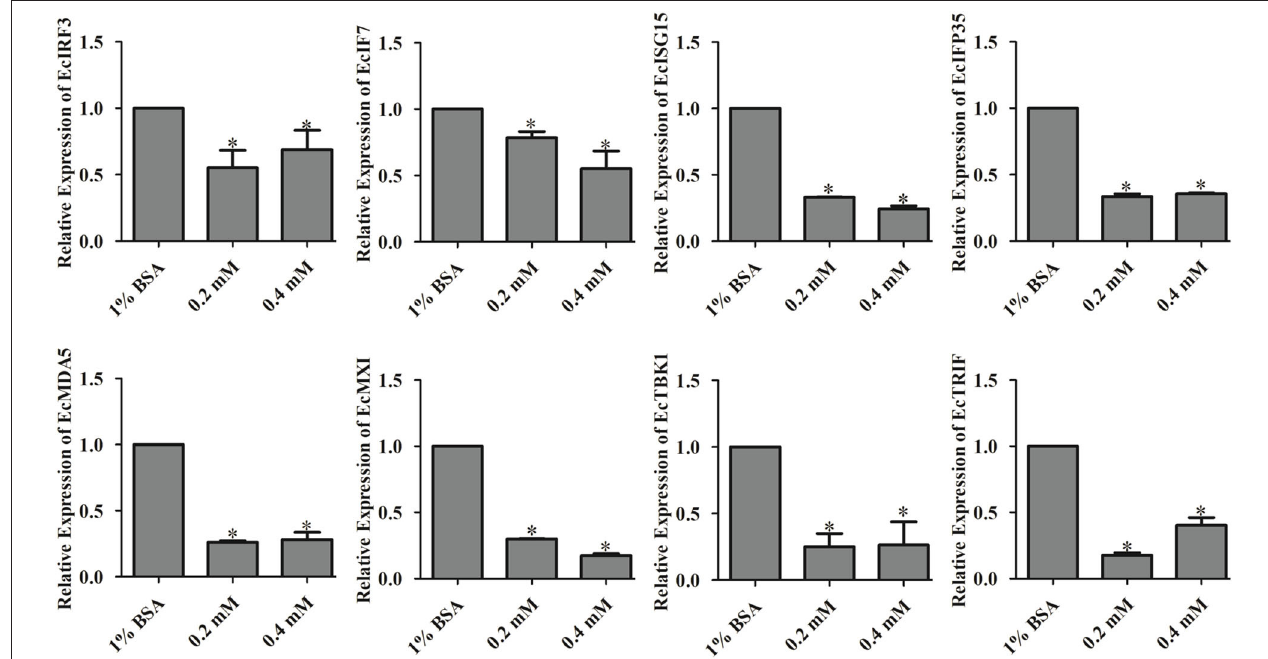
FIGURE 6 | Palmitic acid decreased the expression of interferon related cytokines or effectors. GS cells were incubated with the indicated concentration of palmitic acid (0.2 or 0.4mM) or 1% BSA, then harvested at 24h post-incubation. Expression levels of host IFN associated genes were determined using qRT-PCR. The data are represented as mean ± SD, and the statistical significances were determined with Student’s t -test, n = 3. The significance level was defined as * p <